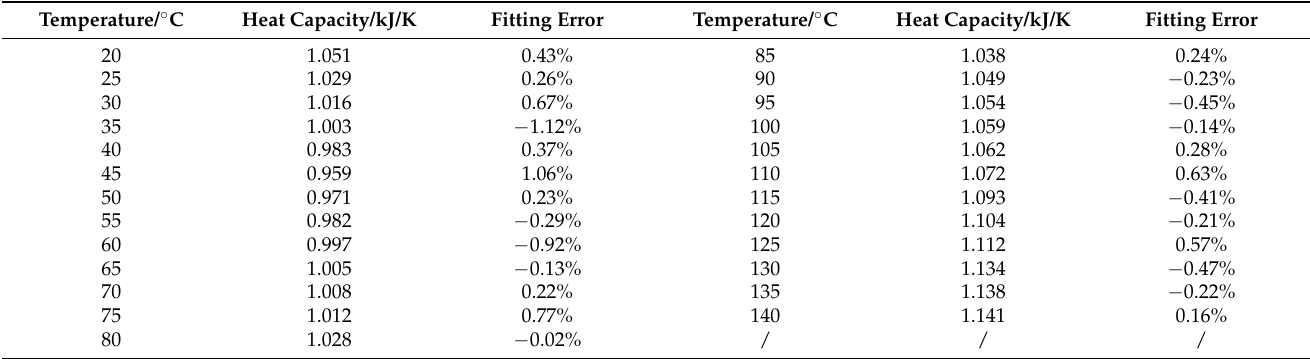
Table 2. Thermal equivalent measurement data of air